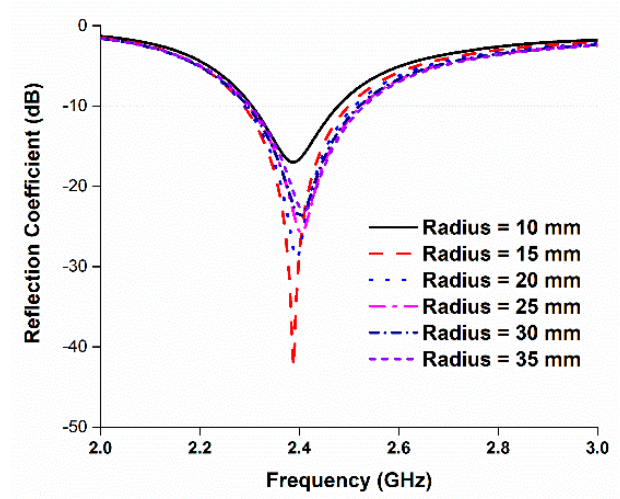
Figure 13. Reflection coefficients of the proposed antenna for different bending (upside-down) radii.